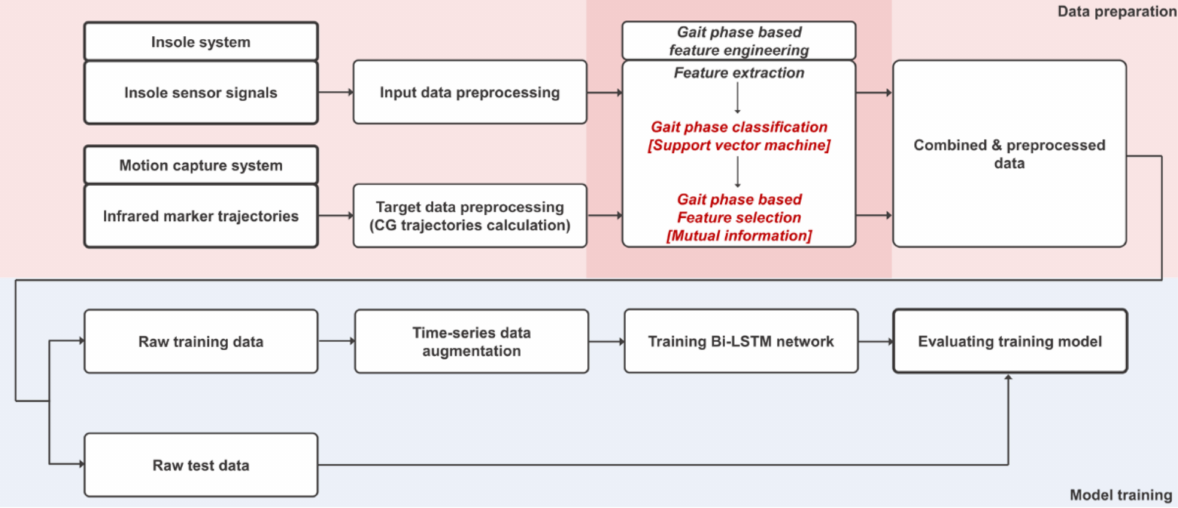
Figure 3. Overall architecture of the proposed protocol for CG prediction using an insole